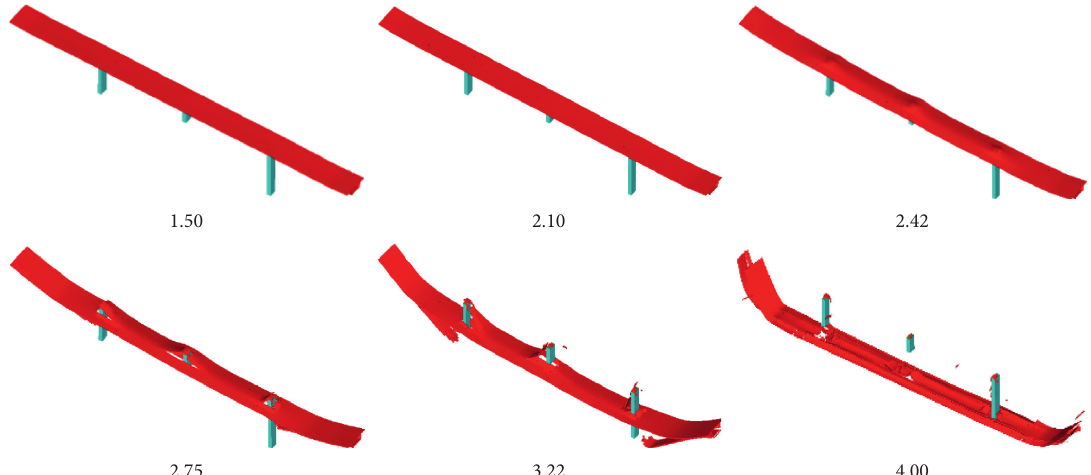
Figure 10: Collapse mechanism of the nonlinear bridge model during the time